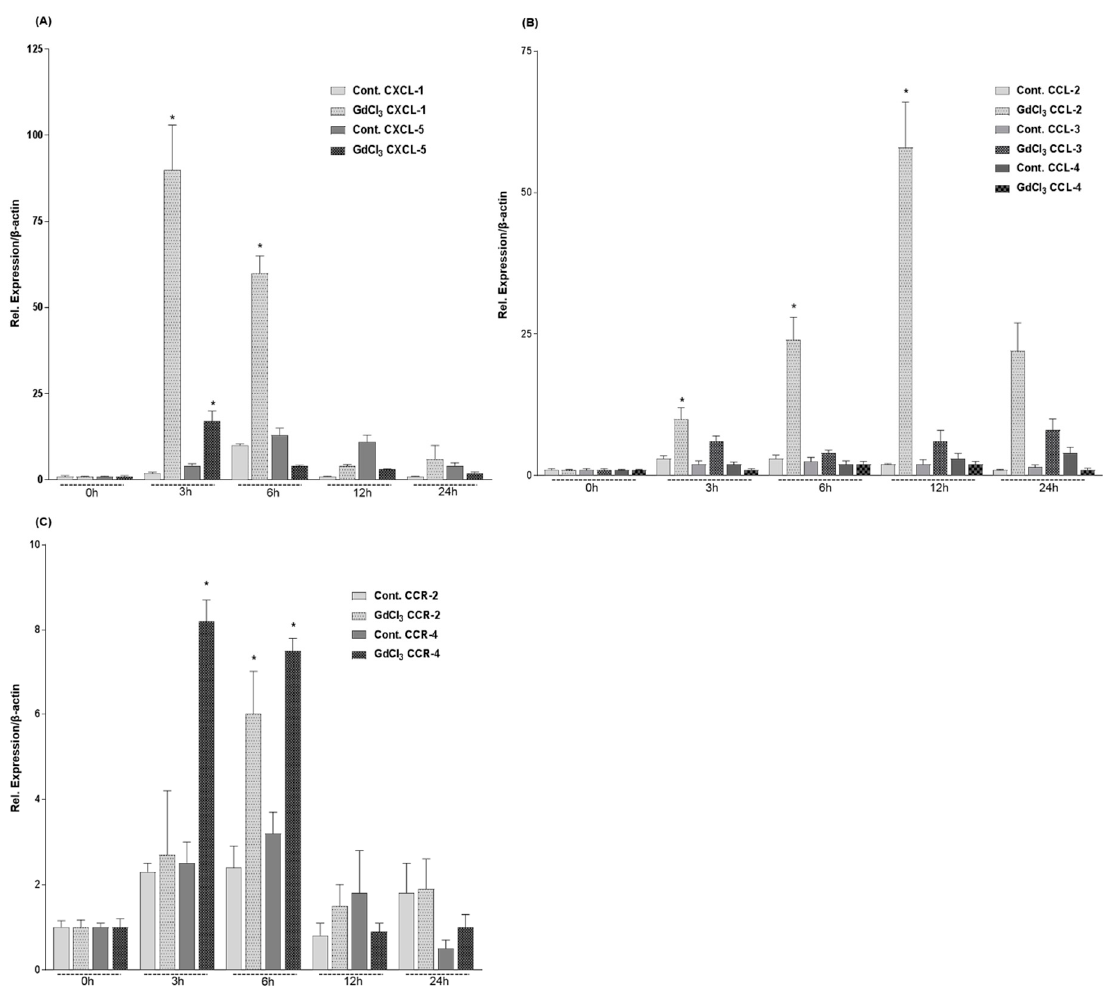
Figure 5. Fold change of mRNA expression of CXC-, CC-chemokines and CC-receptors in intraperitoneally administrated GdCl 3 rat livers at different time points relative to controls. ( A ) Maximum increase of CXCL-1 and CXCL-5 gene expression is detected at 3 h by real-time polymerase chain reaction (RT-PCR). ( B ) CCL-2 gene expression slightly increased at 3 h and 6 h with a maximum at 12 h by RT-PCR, whereas CCL-3 and CCL-4 did not show any increase. ( C ) CCR-2 gene expression significantly increased at 6 h by RT-PCR whereas CCR-4 showed a significant increase already at 3 h. The results were normalized to the housekeeping gene β -actin and experimental errors are shown as ±SEM values of six experiments (in duplicate) compared with controls for each time point (* p < 0.05, analyzed by one-way analysis of variance